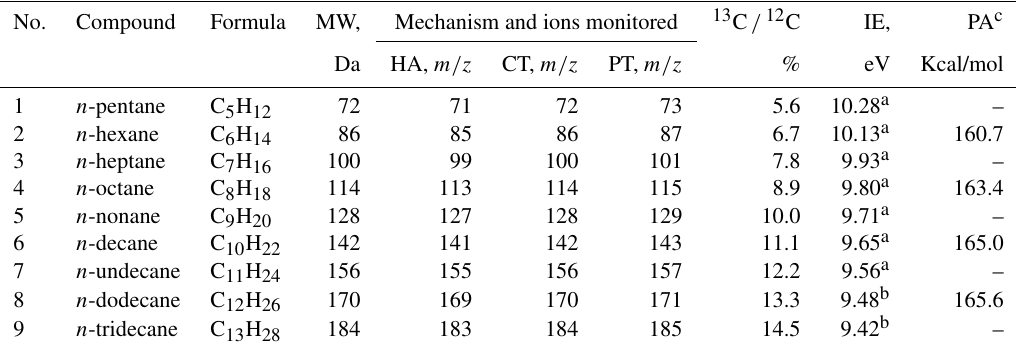
Table 1. n -Alkanes used in experiments: formula, molecular weight (MW), monitored ions indicating hydride abstraction (HA), charge transfer (CT) and proton transfer (PT), isotopic contribution ( 13 C / 12 C), ionization energies (IE) and proton affinities (PA). Water proton affinity: 166 . 5 ± 2kcalmol − 1 (Lias et al., 1984). No. Compound Formula MW, Mechanism and ions monitored 13 C / 12 C IE, PA c Da HA, m/z